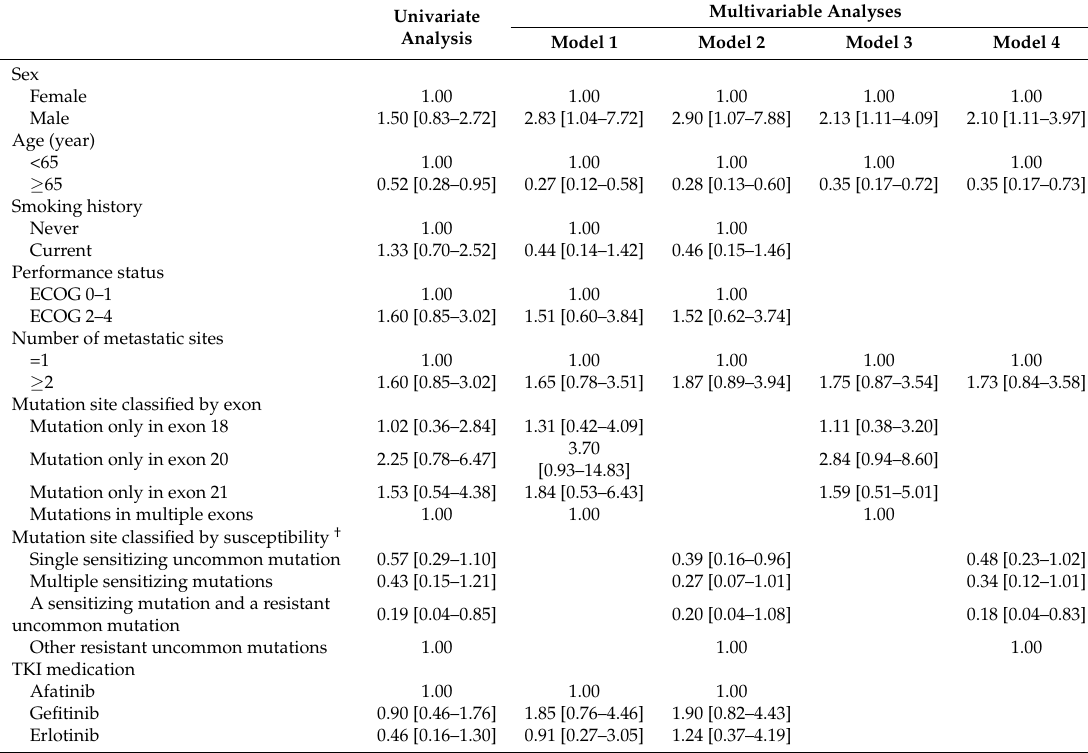
Table 6. Cox proportional hazards regression analyses for identifying the relationship between clinical features and progression-free survival in patients with stage IV lung cancer harboring uncommon mutation receiving first-line